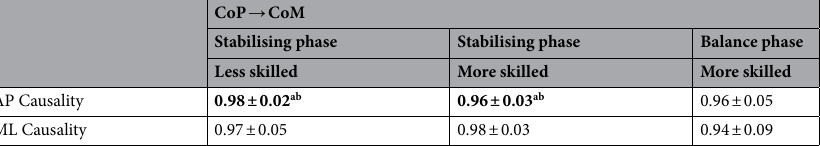
Table 4. CoP to CoM mean ± S.D. causality for ML and AP. Bold values indicates a significant difference between two or more conditions ( P < 0.05). ab P < 0.05 between less and more skilled stabilising phase (independent